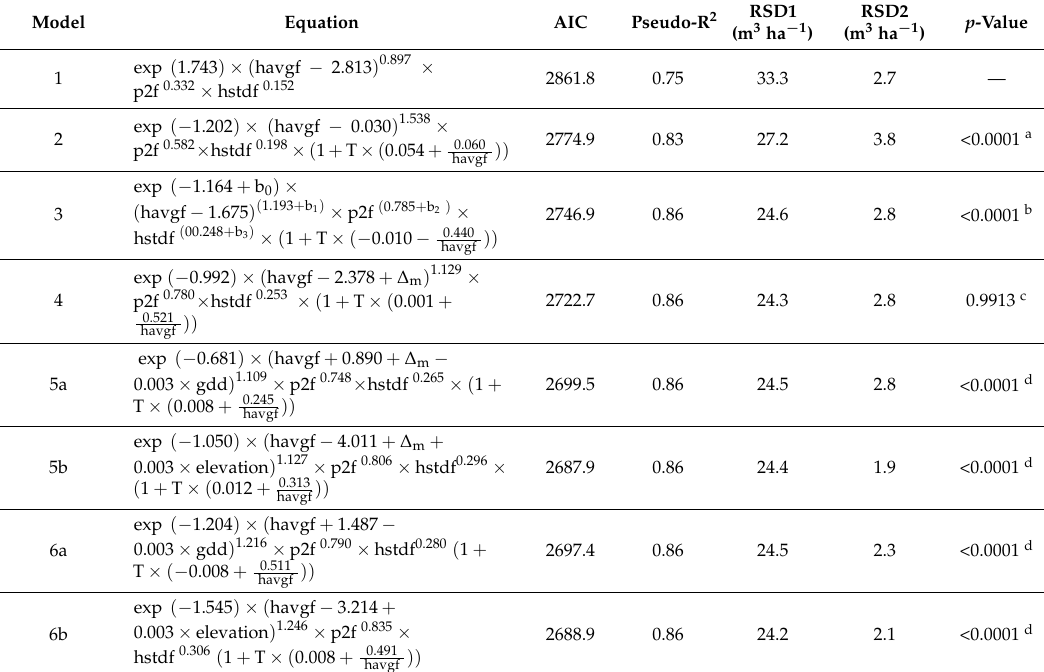
Table 3. Anova comparisons amongst candidate merchantable volume (MV) models.